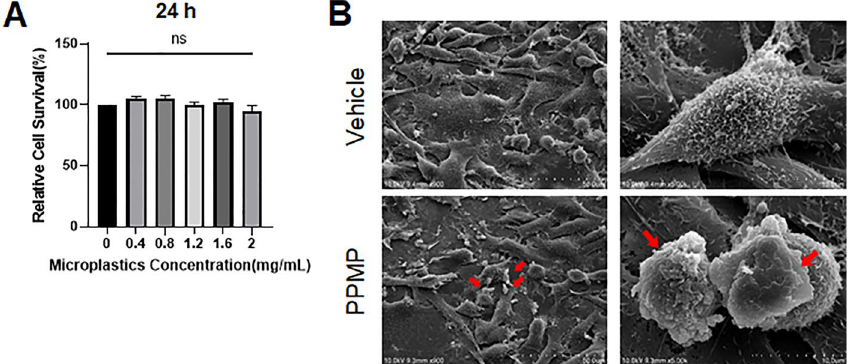
Figure 2. Effect of PPMP on cell viability in human breast cancer cells. ( A ) PPMPs were added to the MDA-MB-231 cells and incubated for 24 hours. The graph shows the survival rates of cells with or without PPMPs (n = 3 independent experiments; one-way ANOVA, * p < 0.05, ** p < 0.01 relative to 0 mg/ml PPMPs). ( B ) SEM image shows MDA-MB-231 cells with or without PPMPs for 24 hours. The red arrows indicate a PPMP on the cell